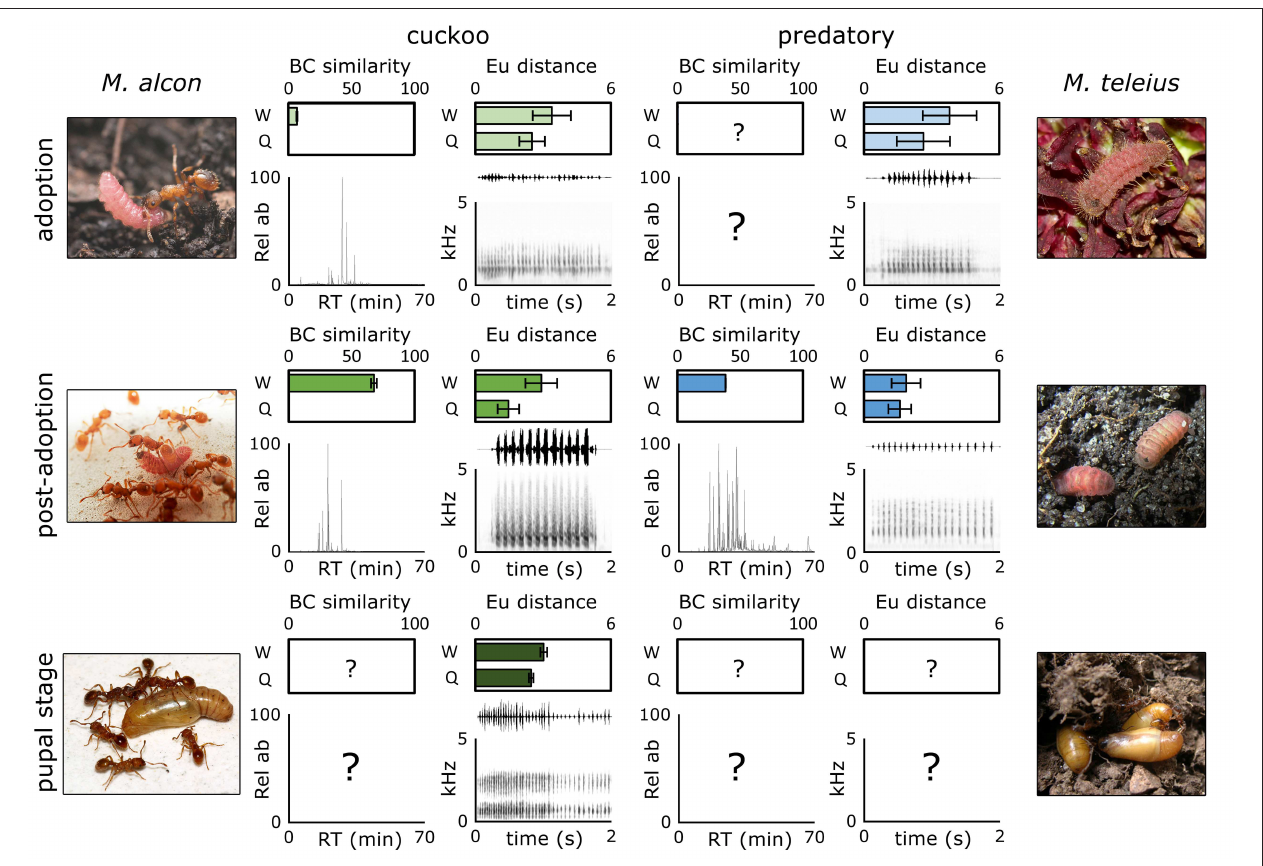
FIGURE 3 | Comparison of chemicals and vibroacoustic patterns used by cuckoo and predatory caterpillars of Maculinea butterflies during pre- and post-adoption and the pupal phase to deceive their Myrmica host ants. Bray-Curtis (BC) similarities calculated on relative abundances (Rel ab) of cuticular hydrocarbons of parasitic caterpillars and host workers in pre-adoption ( Schönrogge et al., 2004) and during the integration phase within host colonies (Witek et al., 2013) are reported as well as Euclidean (Eu) distances between the vibroacoustic patterns of the host queens (Q) and workers (W) and the parasite in pre- and post-adoption ( Sala et al., 2014) and during the pupal stage (Barbero et al., 2009b). Pre-adoption chemical data and vibroacoustic patterns for pupal stage refer to M. rebeli and its host ant M. schencki . Chemical and vibroacoustic patterns showed for the post-adoption phase refer to M. alcon and M. teleius exploiting M. scabrinodis